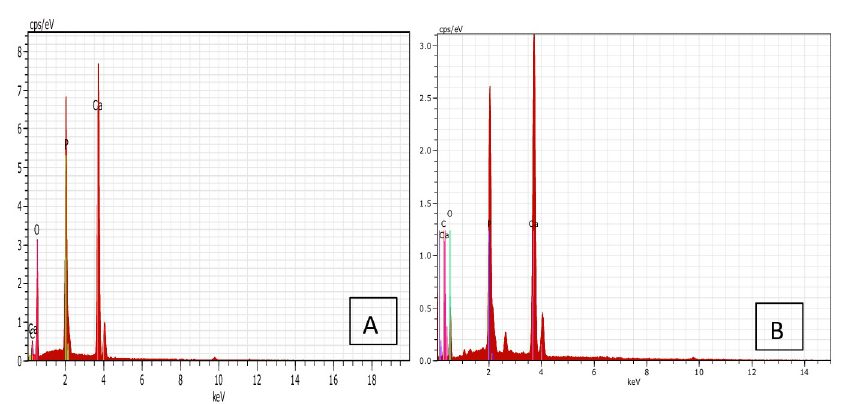
Fig 22. EDX spectrum of HAP. a) before, and b) after immersion in